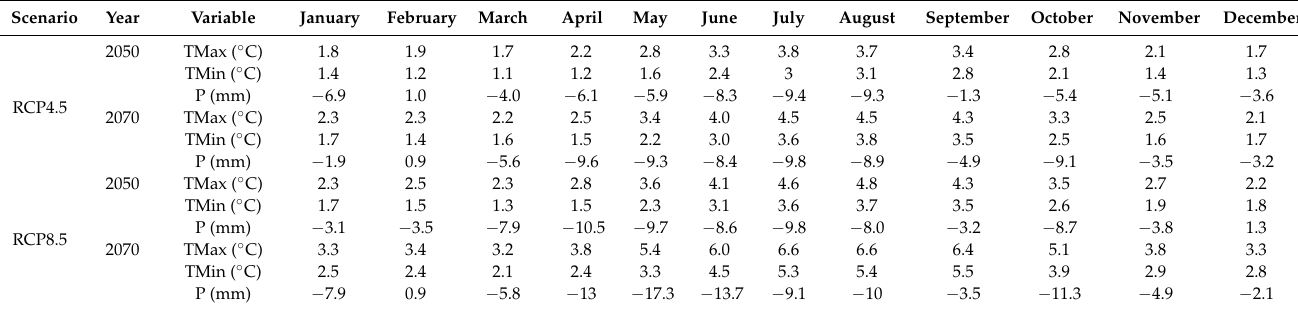
Table 2. Projected changes in the monthly mean temperatures (maximum and minimum) and in precipitation by 2050 and 2070 under the RCP4.5 and RCP8.5 scenarios in Rueda